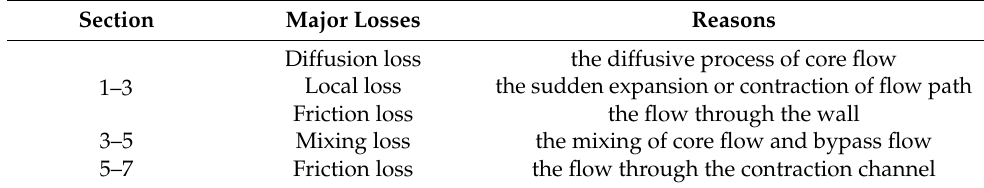
Figure 12. Total pressure recovery coefficient along the flow path under cases with different cooling flow path structure parameters: ( a ) heat shield inlet height r ; ( b ) afterburner annulus height e . Table 3. Major losses of the flow in integrated afterburner and the